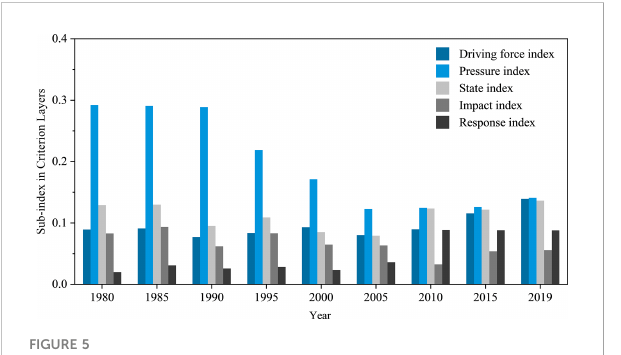
FIGURE 5 The evolution trends of sub-index in criterion layers for the ecosystem health assessment in Laizhou Bay.